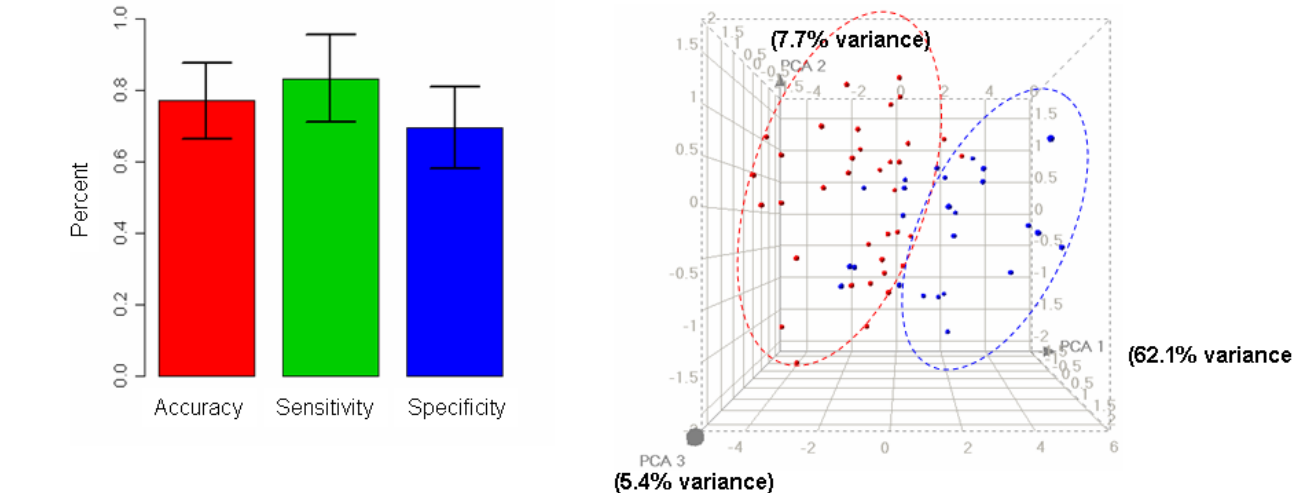
Figure 2. A set of 41 classifier genes were identified via 10-fold cross-validation on the 61-sample training set. (A). Classification accuracy, sensitivity and specificity of the 41 classifier genes, error bar represents 6 1 standard deviation among 100 times of independent 10-fold cross- validation process; (B). 3D Plots of the first three principal components based on PCA analysis. The segregation between TAA and control samples is evident with only a few